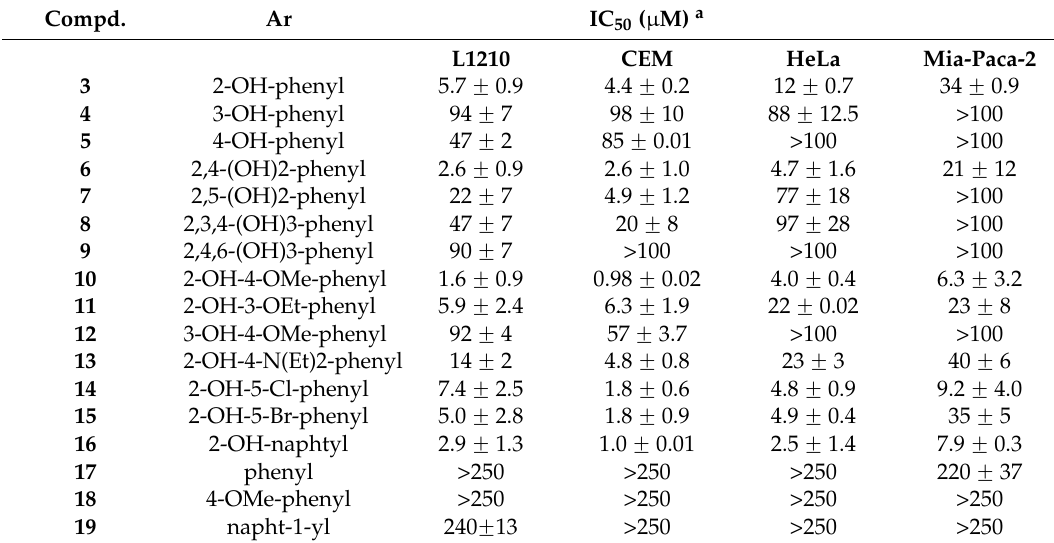
Table 1. Antiproliferative activity of N 1 -(4-arylidene)-1 H -benzo[ d ]imidazole-2-carbohydrazides 3 – 19 .